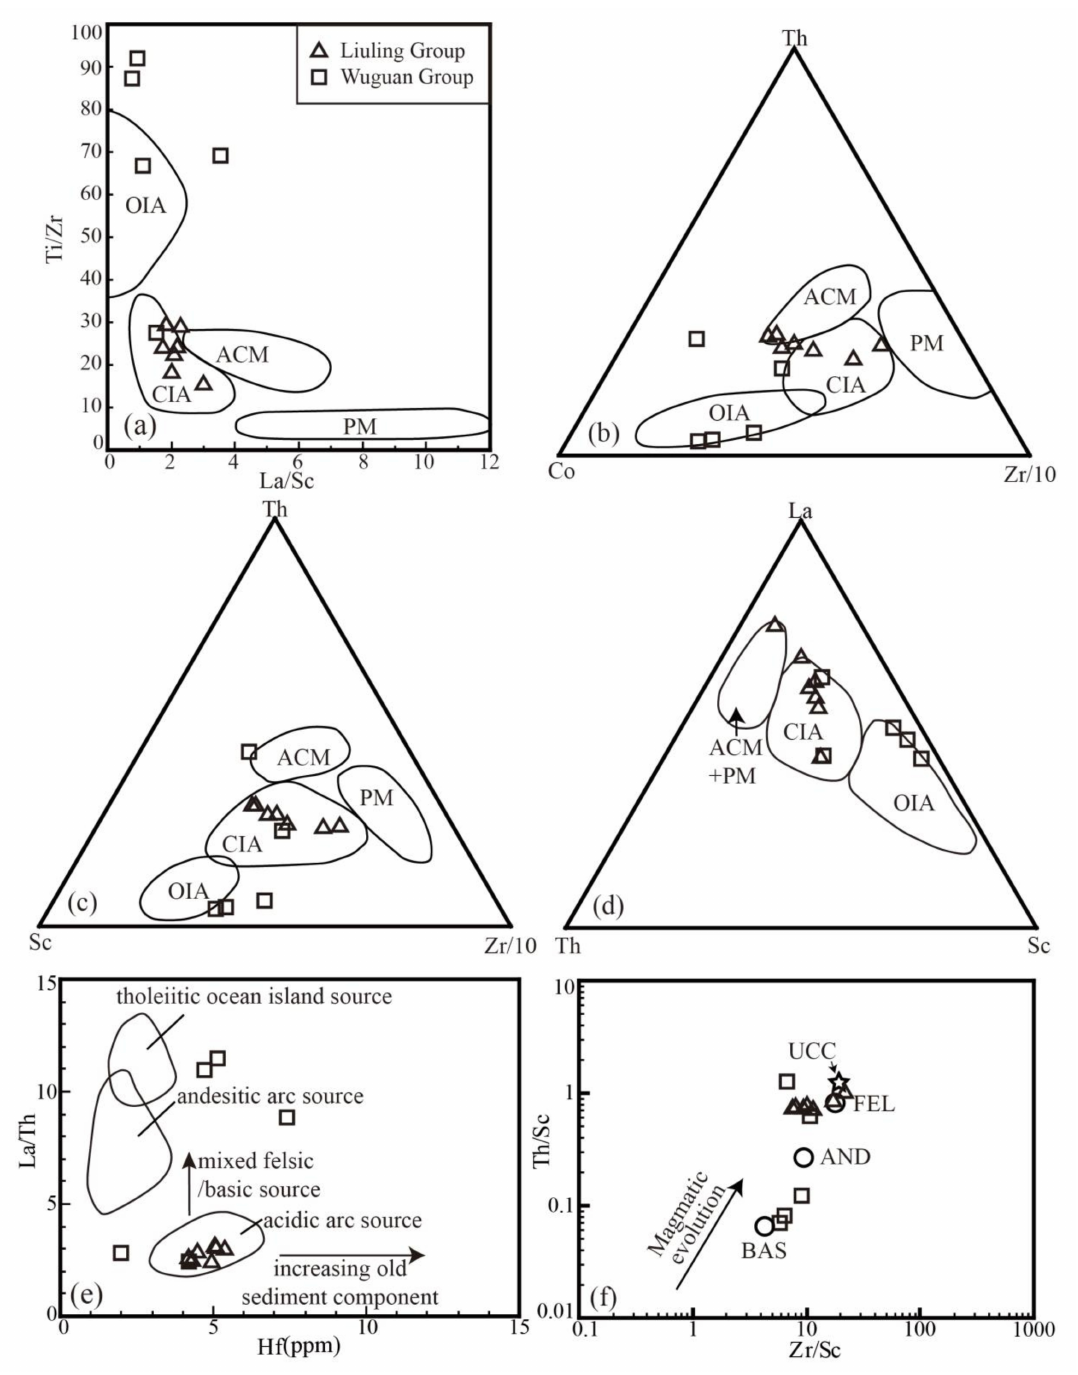
Figure 10. Trace-element tectonic-setting discrimination diagrams for metamorphosed clastic rocks in the Wuguan Complex and Liuling Group. ( a ) Ti/Zr-La/Sc, ( b ) Th-Co-Zr/10, ( c ) Th-Sc-Zr/10 and ( d ) La-Th-Sc spots (after [77]). ( e ) La/Th-Hf diagram (after [59]). ( f ) Th/Sc-Zr/Sc plot (after [78]). Abbreviations: OIA = oceanic island arc; CIA = continental island arc; ACM = active continental margin; PM = passive